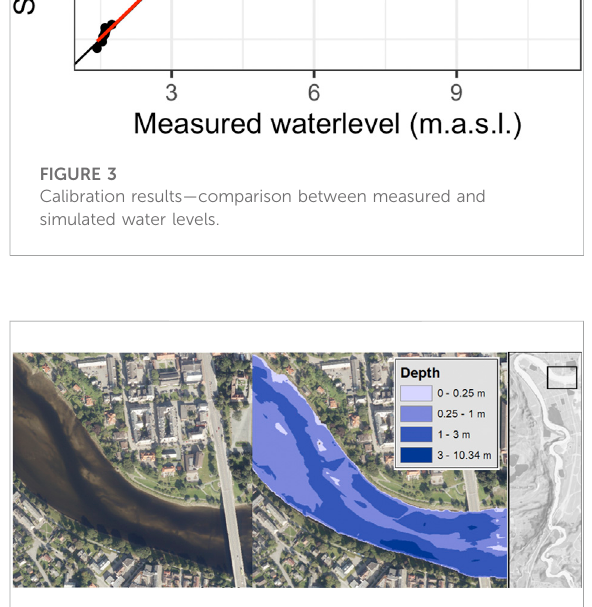
FIGURE 4 Comparison between simulated water surface extent